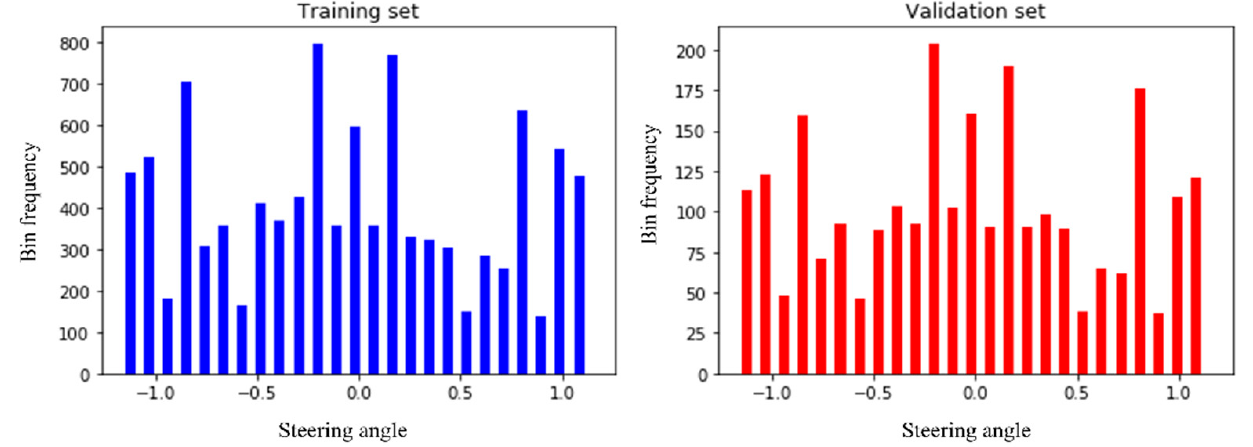
Figure 16. Splitting the images into training and validation set.